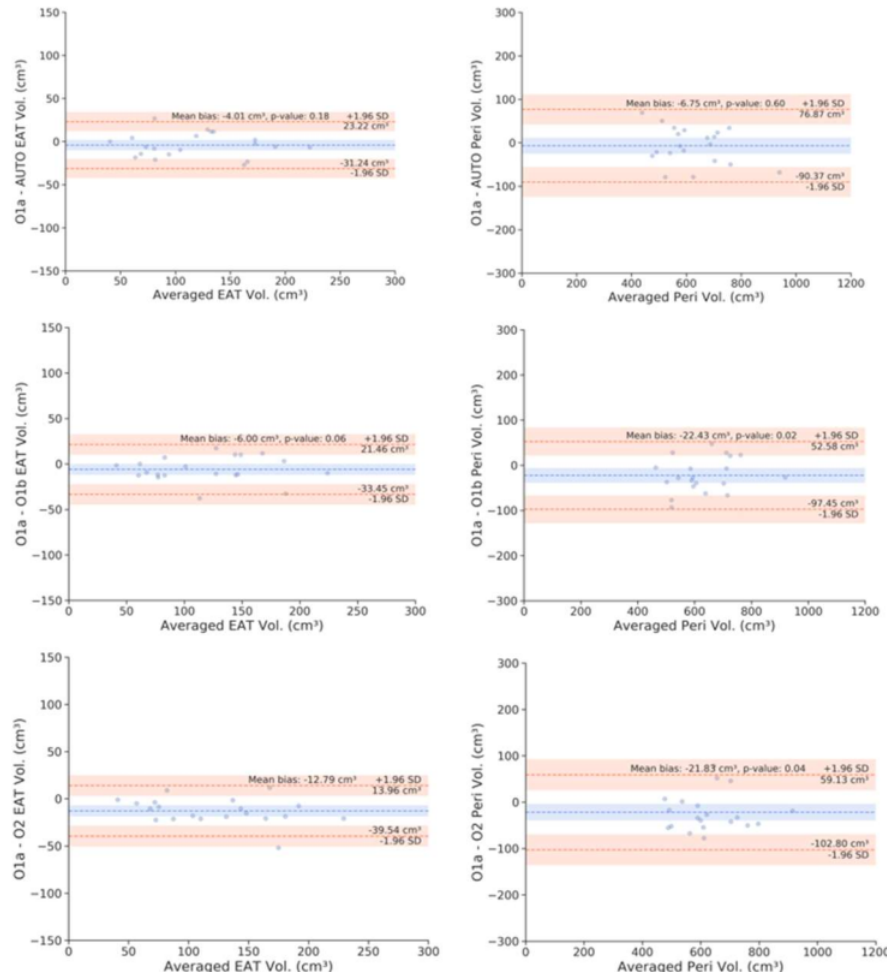
Figure A1. The Bland–Altman analysis for the EAT and Peri volumes between the automatic and manual measurements on the testing dataset. Peri Vol: pericardial volume; EAT Vol: epicardial adipose tissue volume; O1a: initial segmentations made by Observer 1. O1b: second segmentations made by Observer 1; O2: segmentation made by Observer 2. In each Bland–Altman plot, the x-axis denotes the average of the two measurements, and the y-axis is the difference between them. The blue dashed line denotes the mean difference (bias), and the two orange dashed lines denote ± 1.96 standard deviations from the